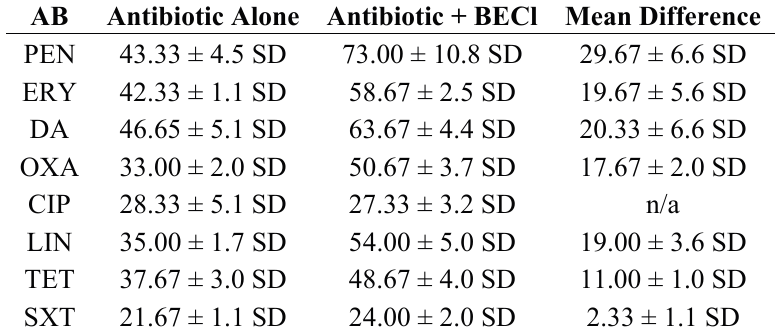
Table 5. Cumulative mean values of inhibitory growth zones for all three investigated oral streptococci strains: S. mutans , S. sanguinis and S. oralis (mm, SD—Standard deviation). AB Antibiotic Alone Antibiotic + BECl Mean Difference